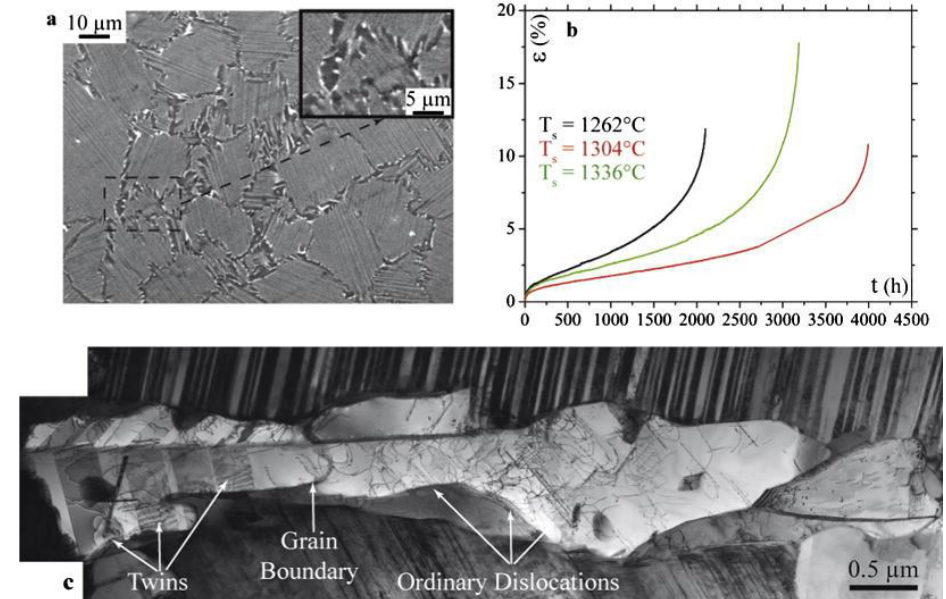
Figure 14. ( a ) Near lamella (NL) microstructure, ( b ) creep curves at 700 °C using stress of 300 MPa, ( c ) RT tensile deformation microstructure for SPS consolidated TNM alloy, reproduced from [106], with permission from Elsevier, 2014.